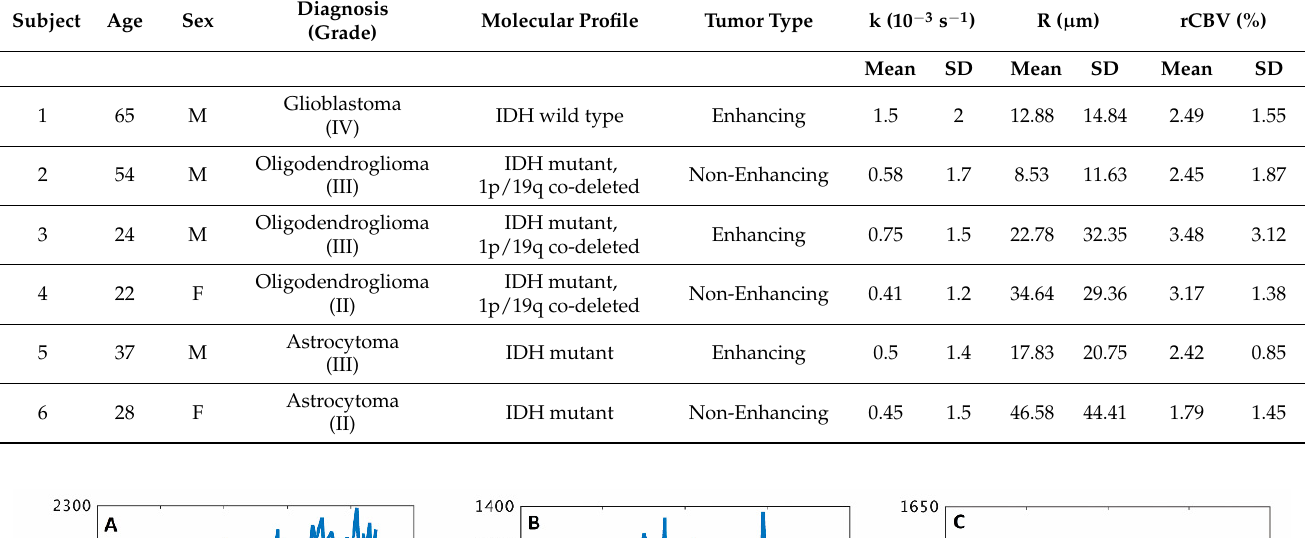
Table 1. Diagnosis of the patient datasets and the mean and standard deviation (SD) in the tumor region of the vessel parameters, k, R and rCBV, obtained from the best match with HEPI signals.